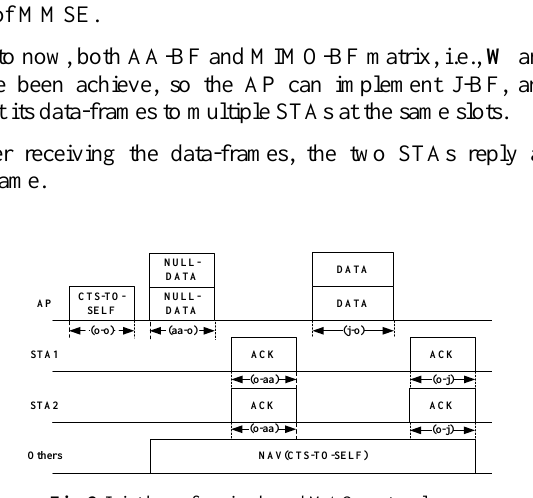
Fig. 2 Joint beamforming based MAC